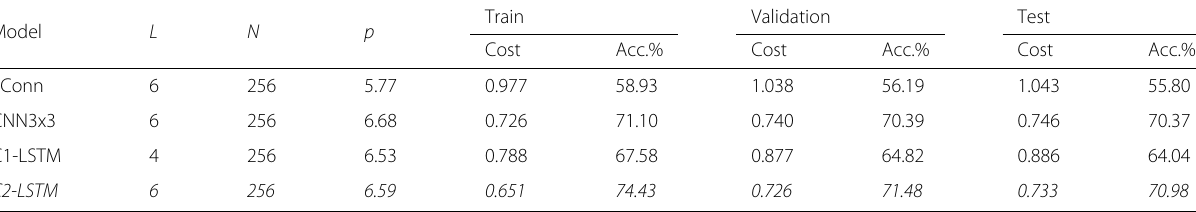
Table 6 Simultaneous speech-music event detection results with different network architectures Model